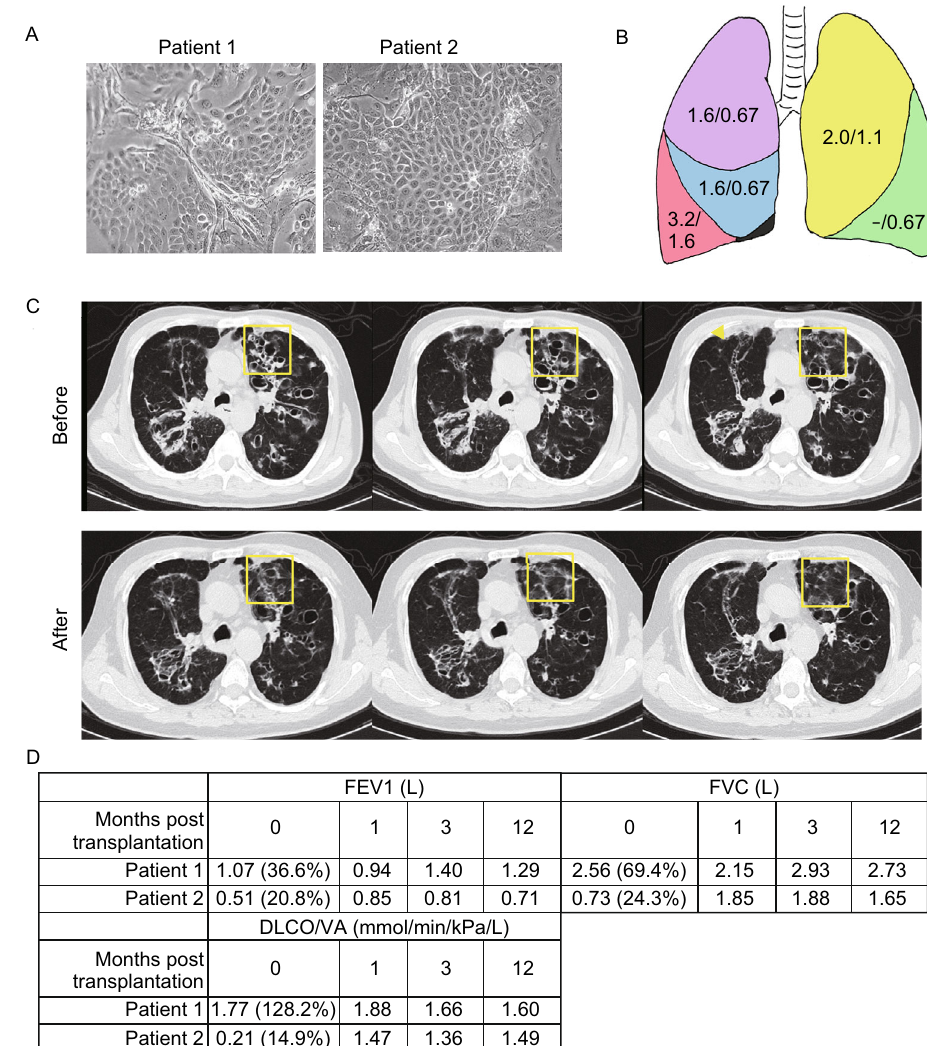
Figure 7. Autologous SOX9 + BC transplantation: a pilot clinical study. (A) Cultured SOX9 + BCs from two patients of bronchiectasis. (B) Diagram showing the number of SOX9 + BCs (×10 7 ) transplanted into each lobe of Patient 1/Patient 2. Five lobes are labeled with different colors. Note the Patient 1 undertook left lower lobectomy a decade ago. (C) Representative images of consecutive CTscan show the regional recovery of bronchiectasis (yellow square) 1 year after autologous SOX9 + BC transplantation in Patient 2. (D) Measurement of pulmonary function and exercise capacity in both patients: FEV1 (forced expiratory volume in 1 second), FVC (forced vital capacity), DLCO/VA (diffusing capacity of the lung for carbon monoxide adjusted by the alveoli volume) were shown as absolute value and percentage to predicted level. For each parameter, percentage >80% was regarded as clinically